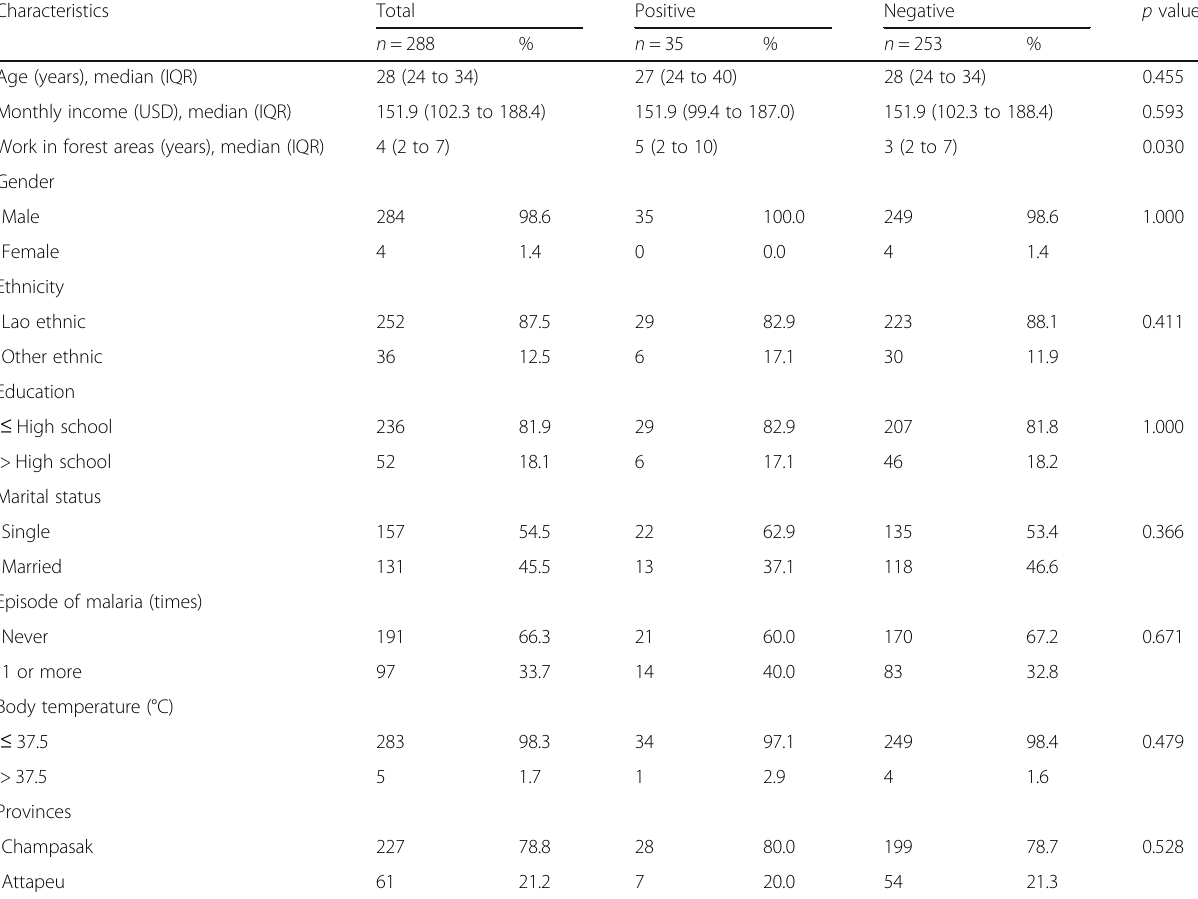
Table 1 Characteristics of military personnel Characteristics